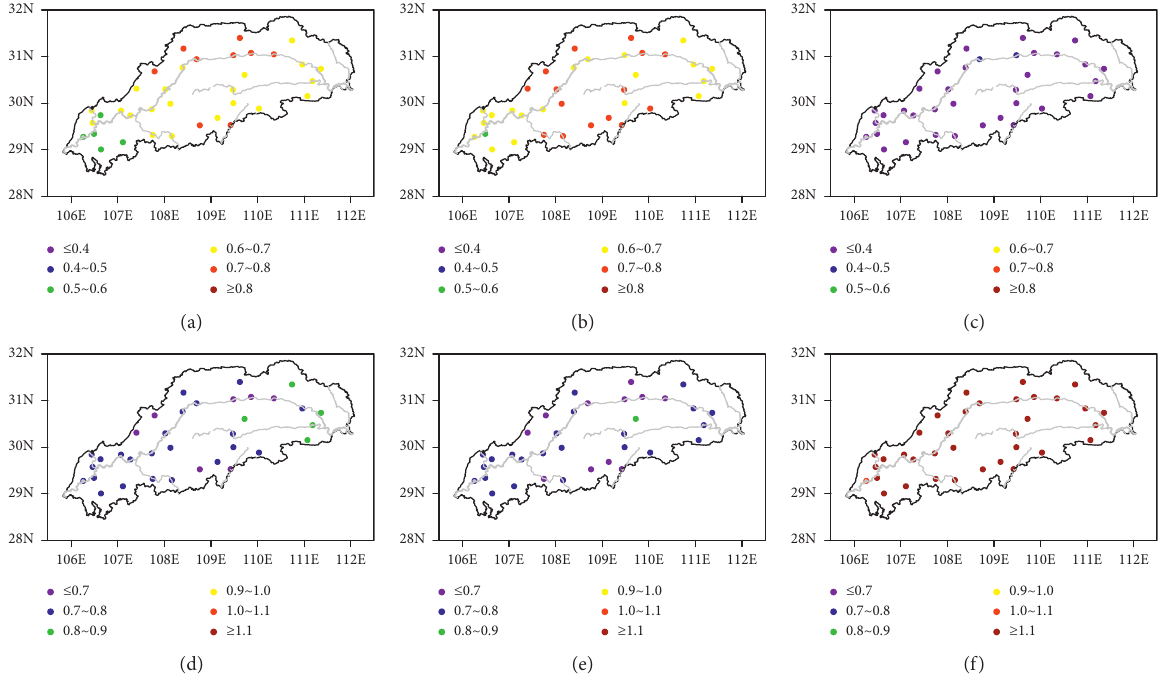
Figure 9: The KGE scores at each gauge station for (a) TRMM, (b) CMORPH, and (c) PERSIANN during the period 2001–2016. Theil’s U score at each gauge station for (d) TRMM, (e) CMORPH, and (f) PERSIANN during the period 2001–2016.